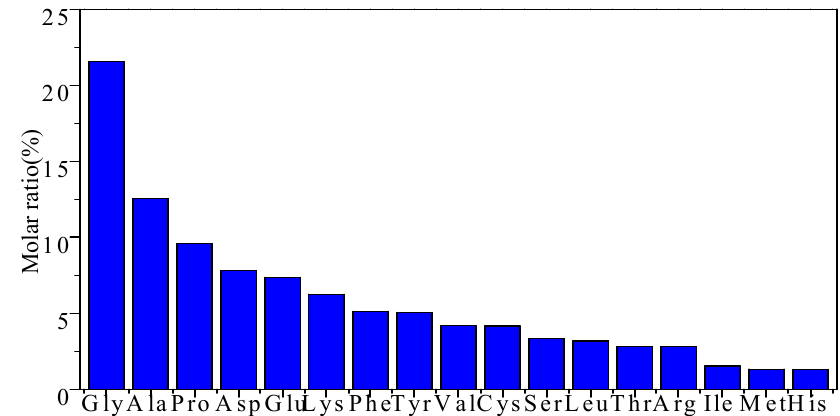
Figure 4. Amino acid composition of extracellular polymers (EPS) from S. epidermidis Y2.